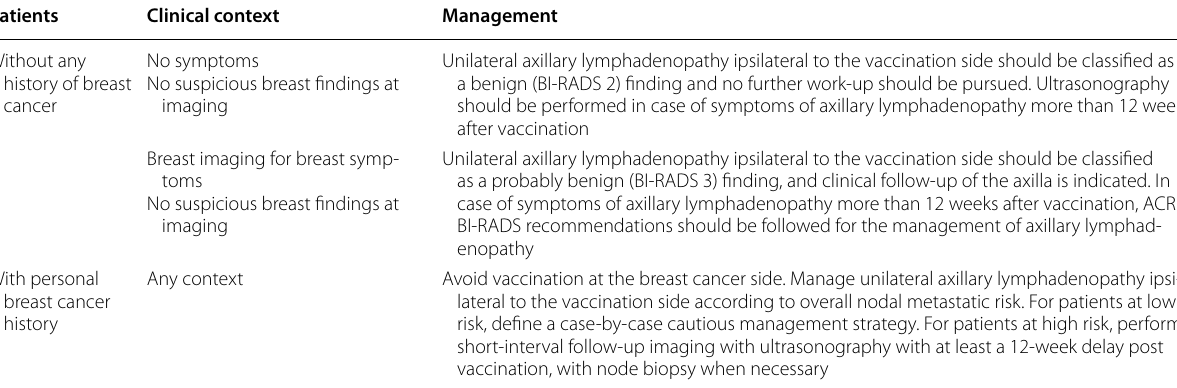
BI-RADS Breast Imaging Reporting and Data System, ACR American College of